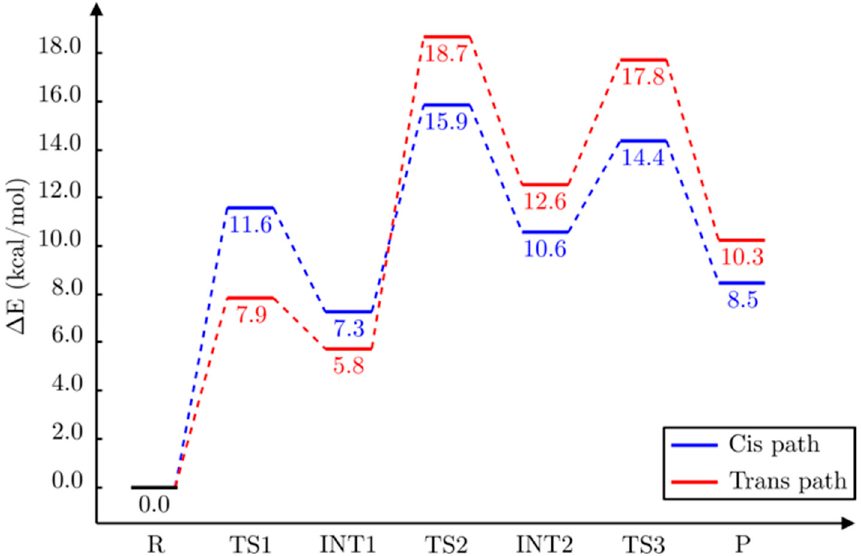
Figure 12. Diagram of potential energies of the stationary structures of the complete mechanism of conversion of LTA 4 to LTB 4 (pro- cis reaction path, in blue) catalysed by LTA 4 H and of the competitive pro- trans reaction path (in red).